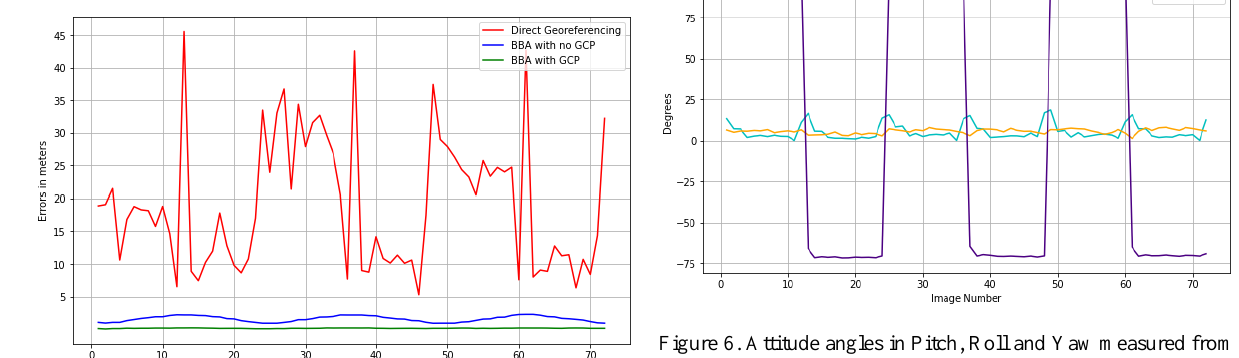
Figure 6. Attitude angles in Pitch, Roll and Yaw measured from the